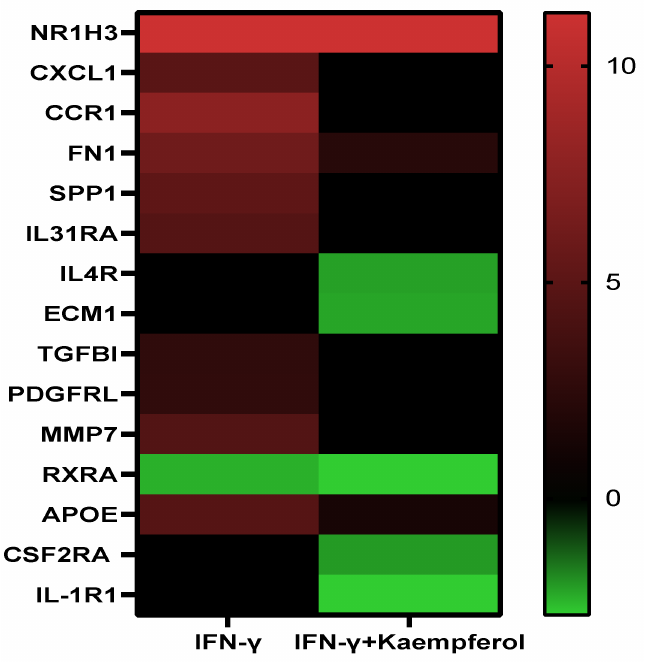
Figure 7. Heatmap displaying the levels of differentially expressed genes in the presence of 130 nM IFN- γ and 130 nM IFN- γ + 10 µ M kaempferol. Color code: red for upregulated, green for downregu- lated genes, and black for non-significant expression difference.